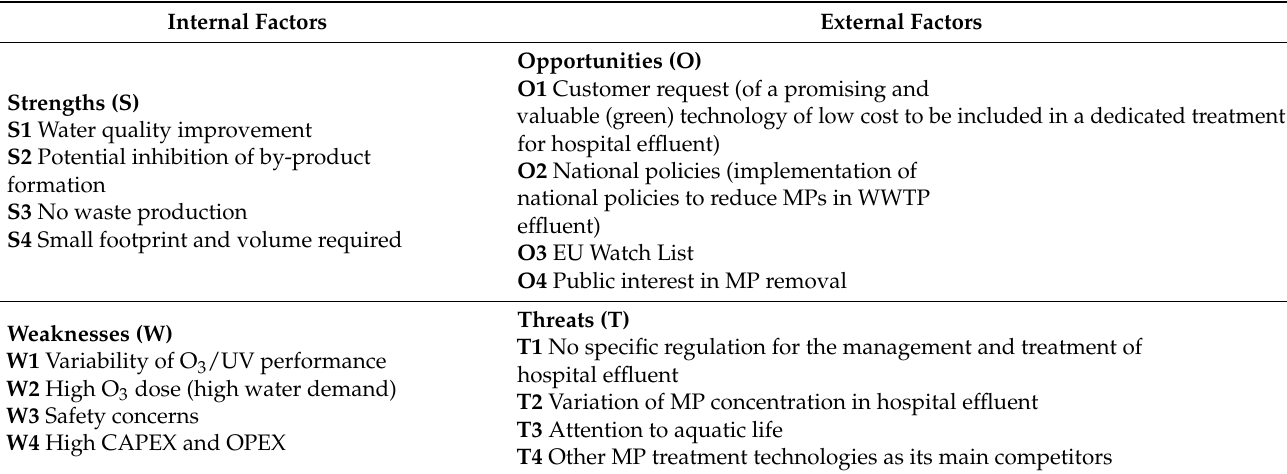
Table 4. SWOT matrix for O 3 /UV